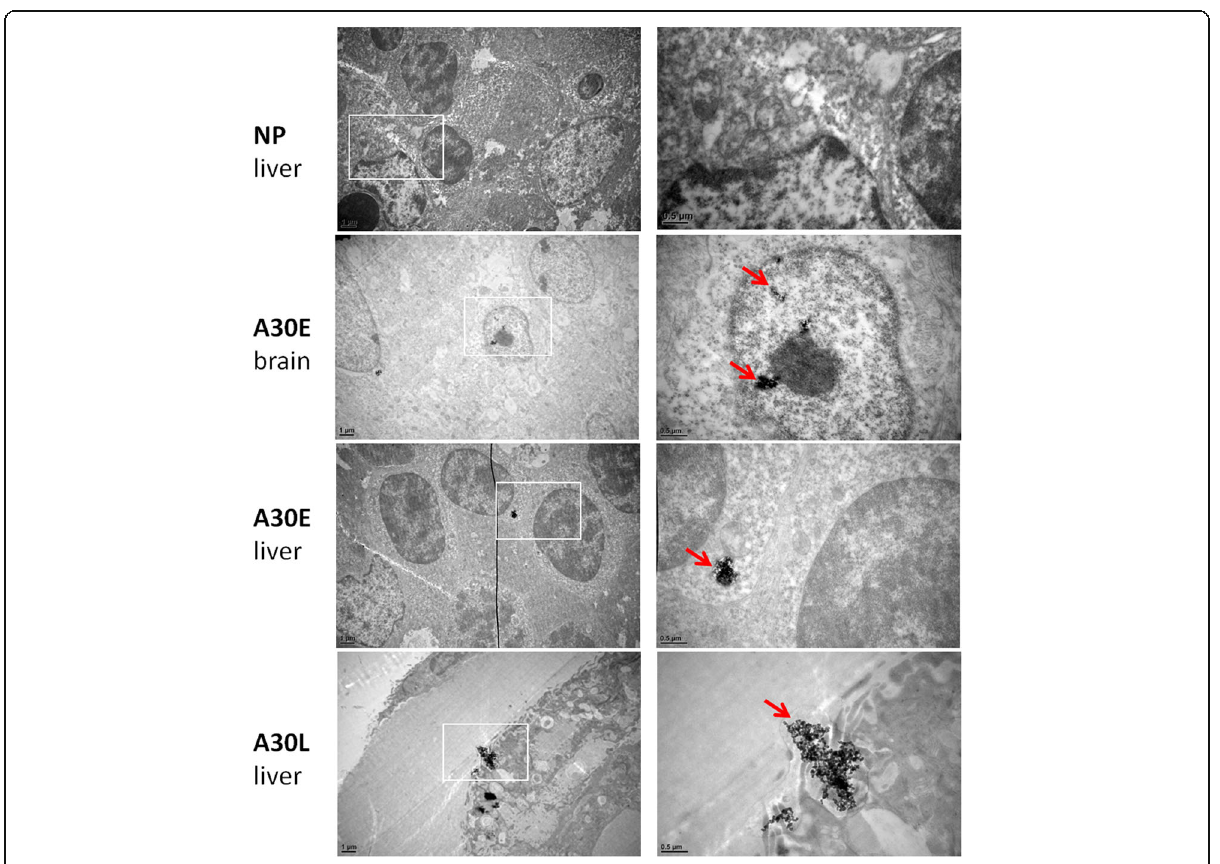
Fig. 7 TEM image of E16.5 fetal brain and liver after A30 maternal exposure from E5.5 (A30E) or E11.5 (A30L). Imaging was performed under Tecnai Spirit transmission electron microscope (FEI, U.S.A.). A30 could be found in the fetal liver of the A30E and the A30L groups as well as the fetal brain of the A30E group. The scale bar of left-hand pictures is 1 μ m; the amplified images of internal frame area in the left column pictures are shown on right column with scale bar of 0.5 μ m. Representative images from three fetal samples of each group are shown